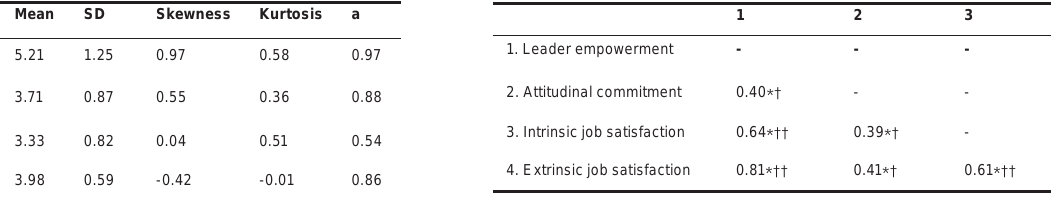
TABLE 2 Descriptive statistics and Cronbach alpha coefficients of the measuring instruments